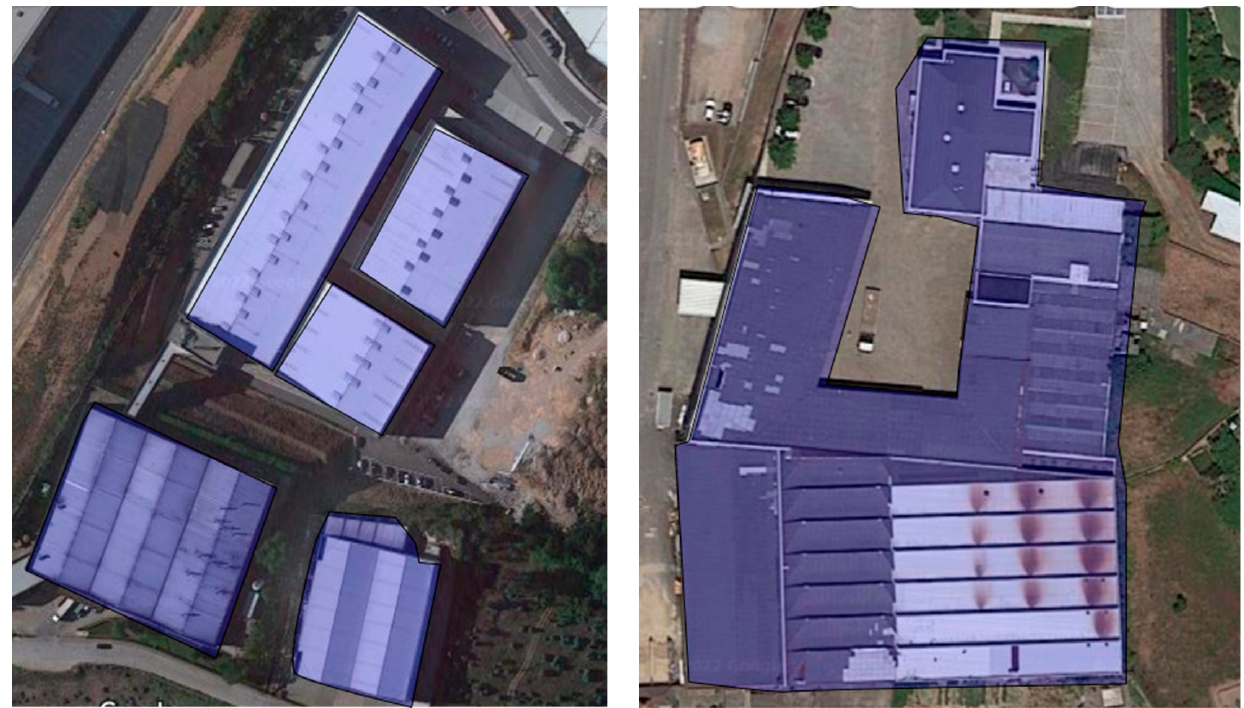
Figure 4. Some of the industrial buildings used for the image database composition.